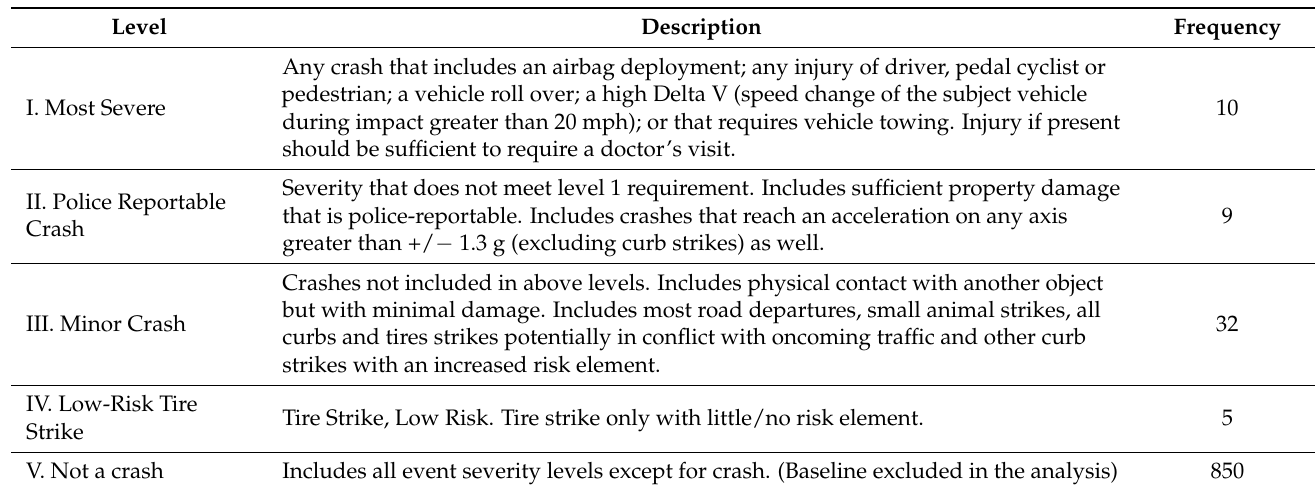
Table 5. Definition of crash severity in NDS database. (Reproduced from: SHPR 2